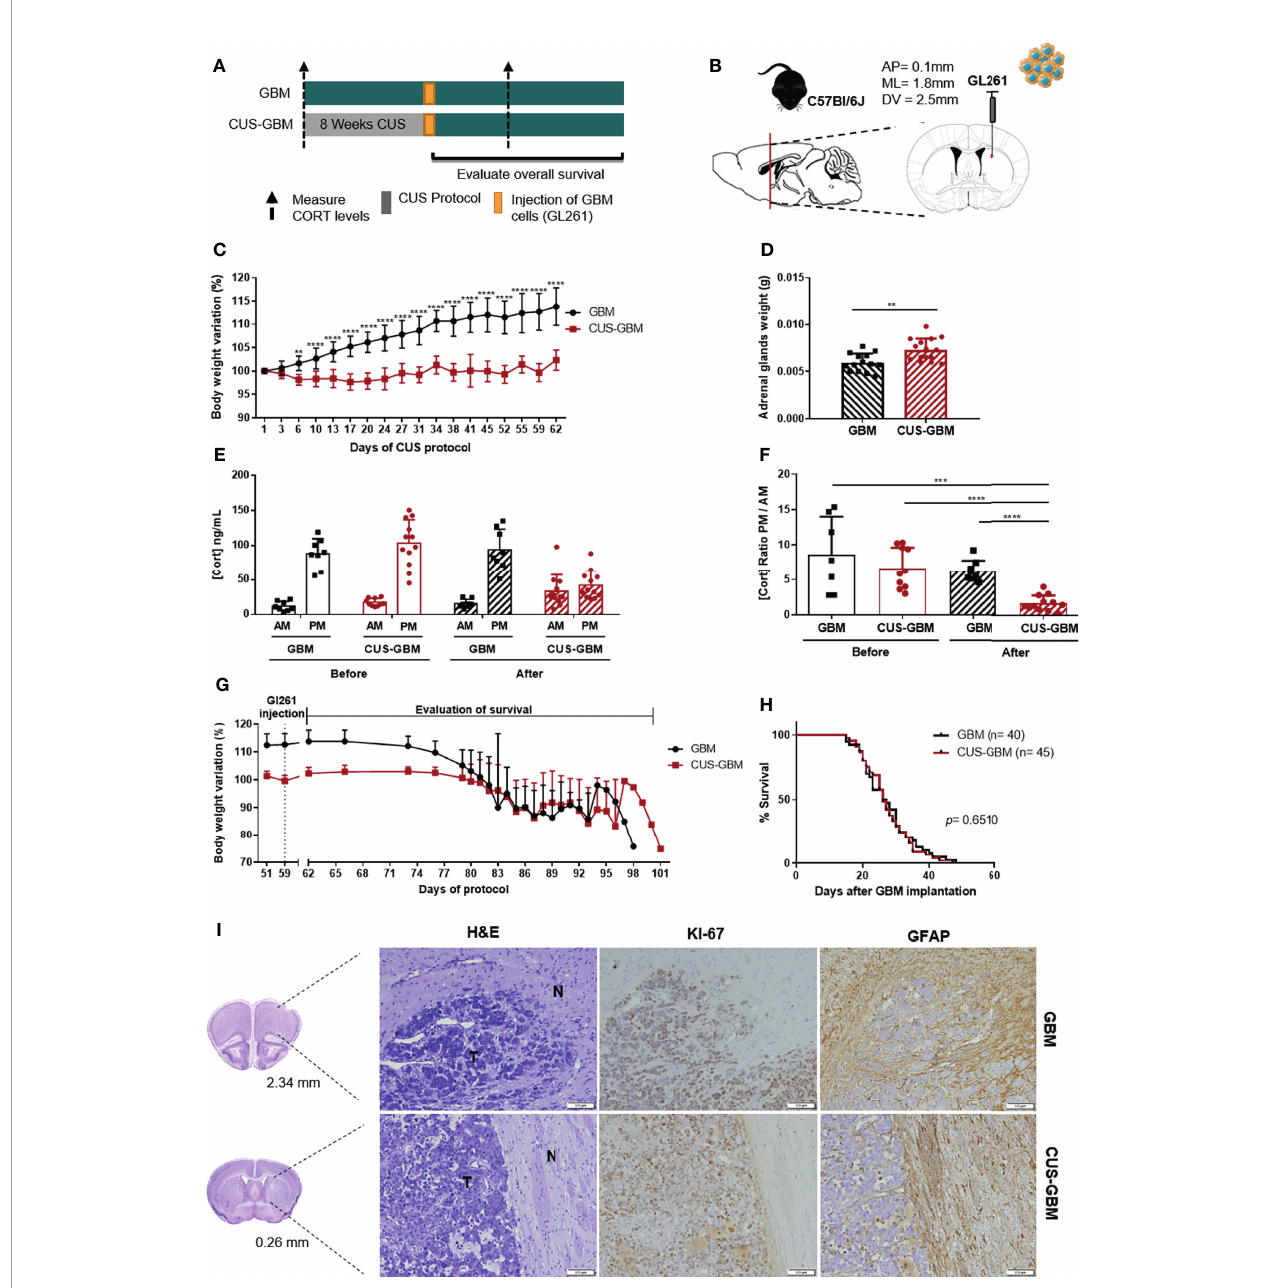
FIGURE 3 | Chronic unpredictable stress does not affect overall survival of an immunocompetent mouse GBM model. (A) Experimental Design. C57BL/6J mice were subjected to 8 weeks of CUS before (CUS-GBM group) the orthotopic injection of a mouse GBM cell line, GL261; the control group was subjected to regular handling (GBM group). (B) Sagittal and coronal representation of the stereotactic injection site of GL261 cells into the mouse brain with the following coordinates from bregma (AP = 0.1 mm; ML = 1.8 mm; DV = 2.5mm). (C) Body weight variation percentage from initial weight of GBM (black; n = 15), and CUS-GBM (red; n = 15) groups during the protocol of CUS before GBM implantation representative of the four independent experiments. (D) Adrenal glands weight upon sacri fi ce of animals (GBM, n = 14; CUS-GBM, n = 15). (E) Serum CORT levels of GBM and CUS-GBM groups from morning (AM) and evening (PM) blood collections before and after the CUS protocol (GBM, n = 8; CUS-GBM, n = 12). (F) Ratio of evening (PM) per morning (AM) CORT circulating levels of GBM and CUS-GBM groups before and after the CUS protocol (GBM, n = 8; CUS-GBM, n = 12). (G) Body weight variation percentage from initial weight of GBM (black; n = 15), and CUS-GBM (red; n = 15) groups after GBM implantation representative of the four independent experiments. (H) Kaplan – Meier survival curves of GBM (black, n = 40), and CUS- GBM (red, n = 45) groups. (I) Representative coronal sections of the mouse brain area (GBM at 2.34 mm and CUS-GBM at 0.26 mm). Hematoxylin-eosin staining of mice brains presenting a tumor area (T) and surrounding non-tumor brain tissue (N). Immunohistochemical staining for Ki67 and GFAP of mice brains orthotopically- injected with GL261 cells of GBM and CUS-GBM groups. Magni fi cation of 100x (Scale = 100 m m). ** p < 0.01; *** p < 0.001; **** p < 0.0001. Data from 4 independent in vivo